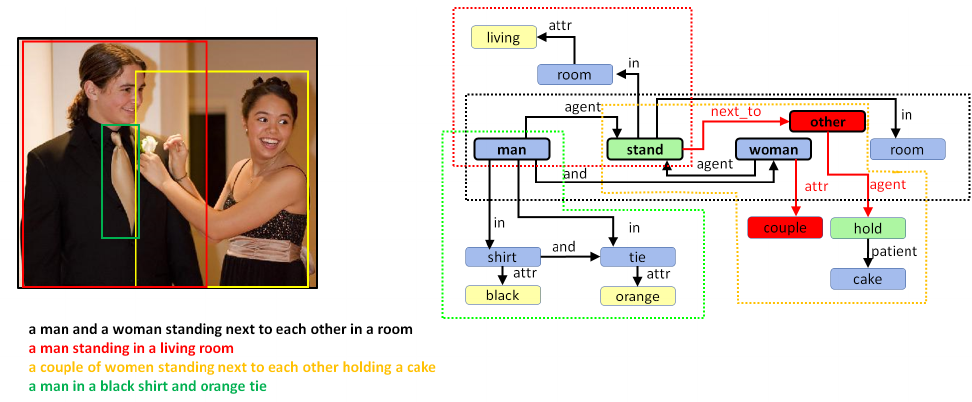
Figure 19. Holistic scene graph showing caption generator making wrong assumptions about objects beyond the bounding box.